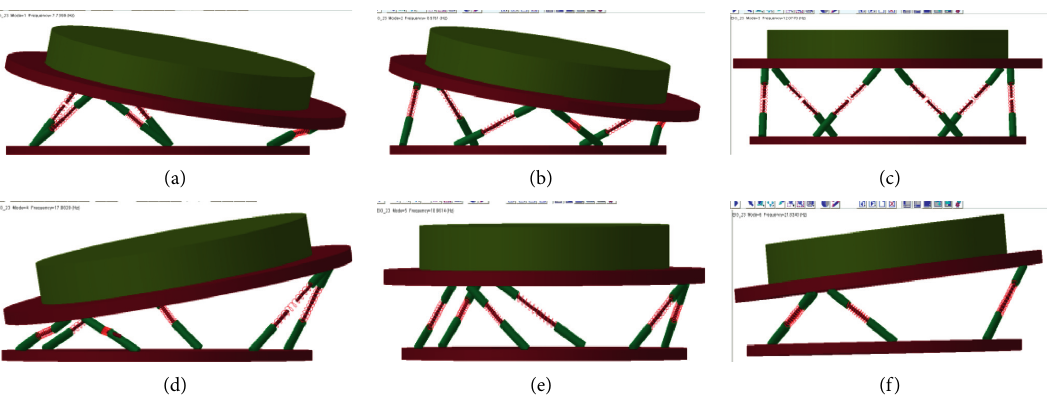
Figure 6: The first six modes of the microvibration suppression device. (a) First-order mode. (b) Second-order mode. (c) Third-order mode. (d) Fourth-order mode. (e) Fifth-order mode. (f) Sixth-order mode.